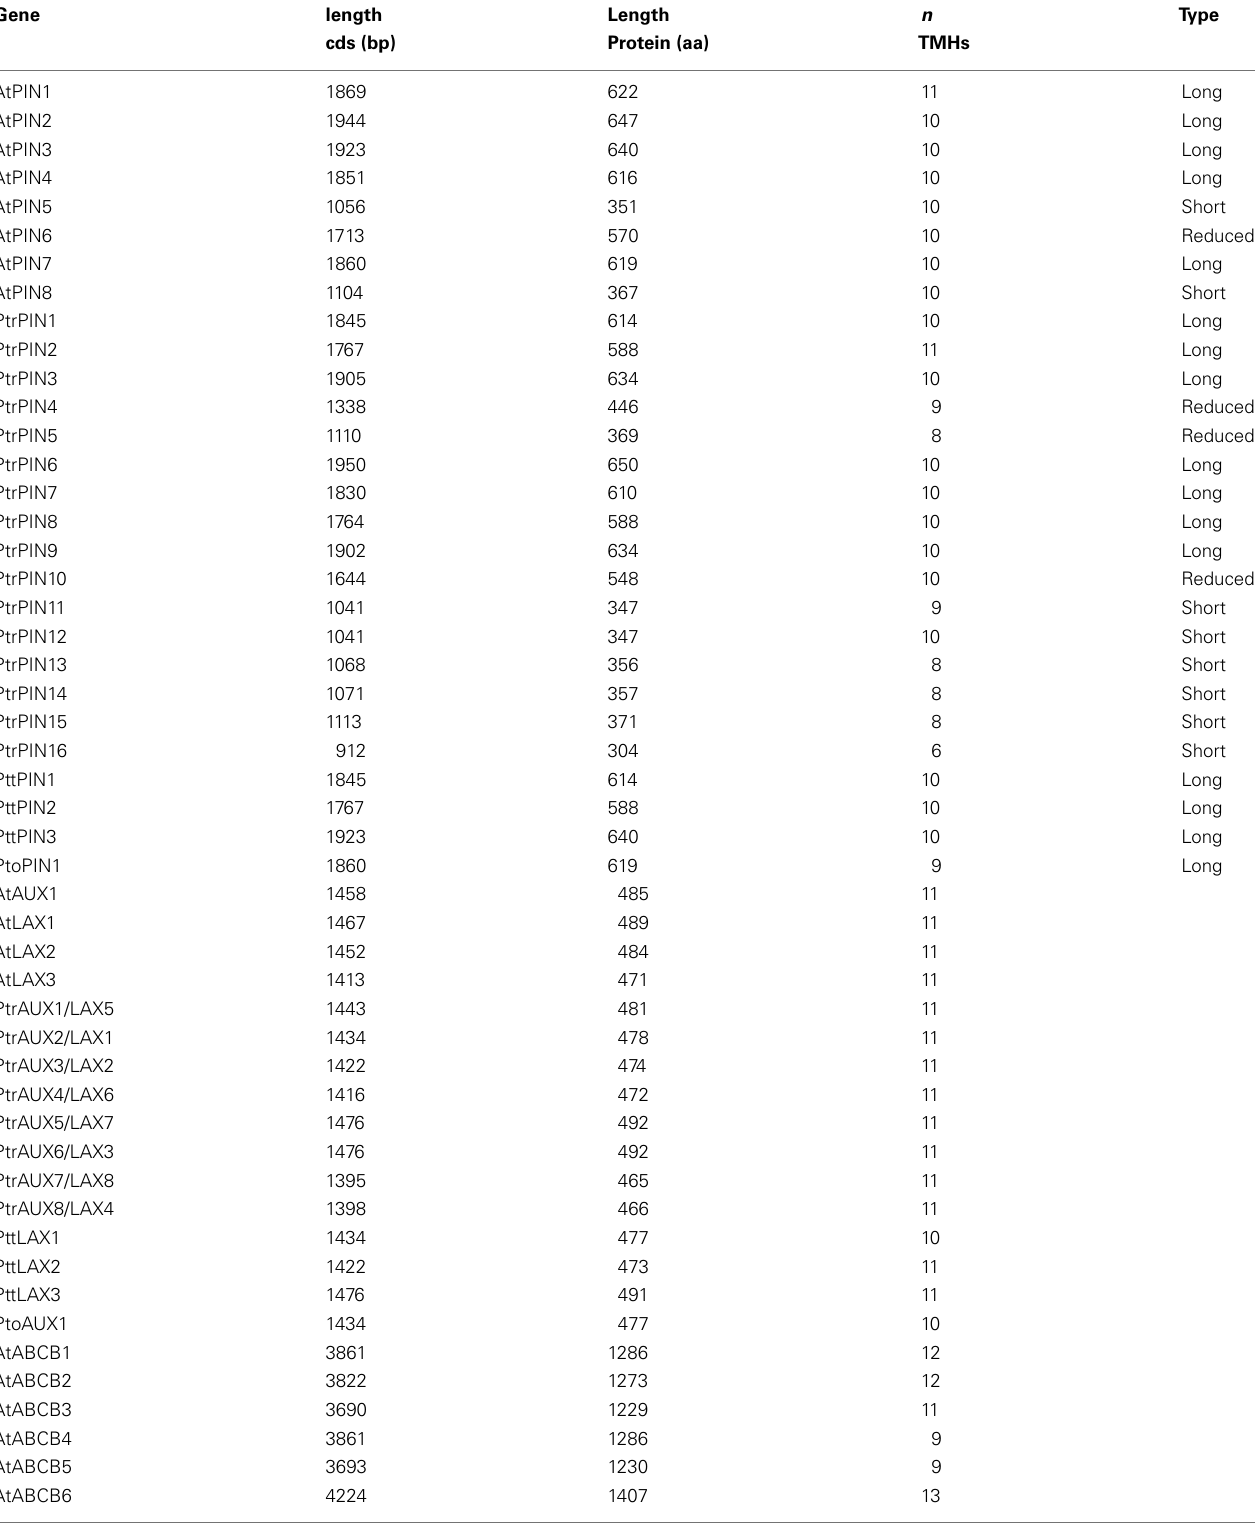
TableA3 | Summary of the protein characteristics of the PIN,AUX/LAX, andABCB families of Populus trichocarpa , Populus tomentosa , Populus tremula × tremuloides , and